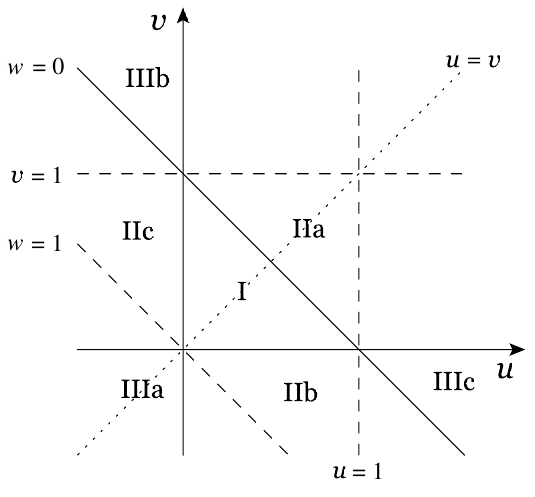
Figure 1. Kinematics of the three-point form factor in the ( u, v ) plane, where w = 1 − u − v . The Euclidean region is the triangle 0 < u, v, w < 1 , and the solid edges bounding it correspond to the near-collinear limits where the FFOPE data can be accessed. The other physical regions are described further in the